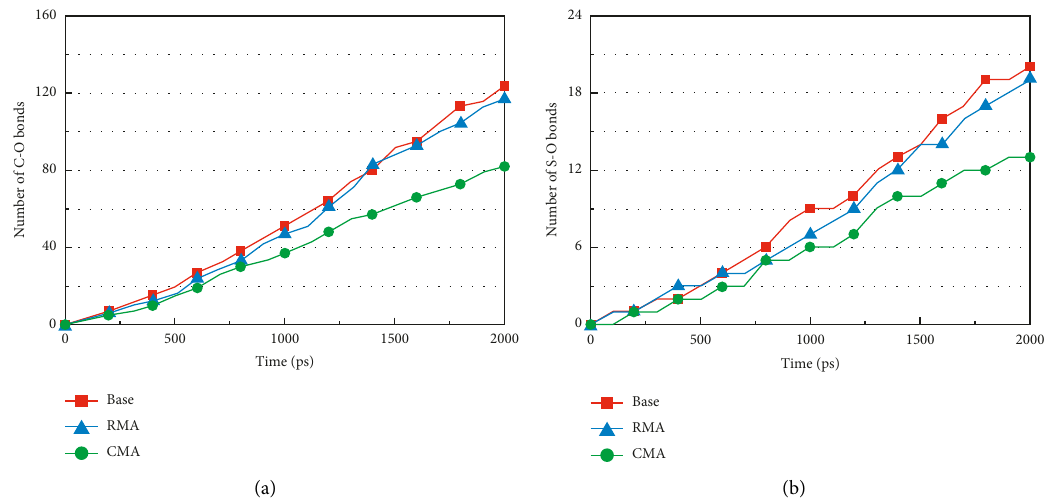
Figure 7: Number of C–O and S–O bonds in the base and modified asphalt samples with aging time obtained from ReaxFF MD